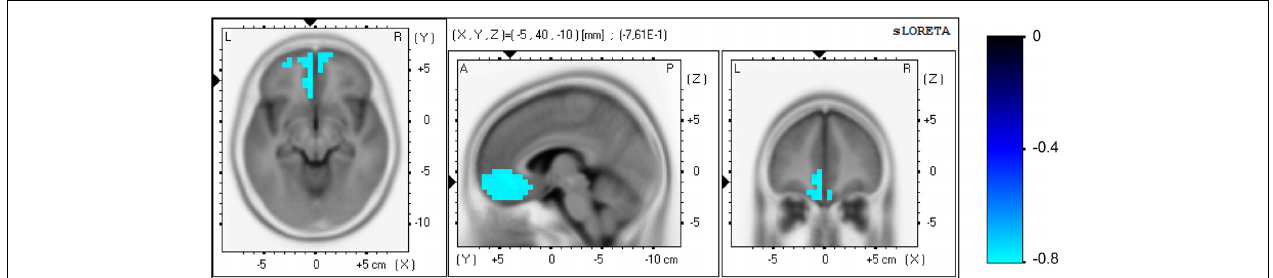
FIGURE 5 | Correlation analysis for the NF group at the brain source level between the pre vs. post increase in the elapsed time variable of the PASAT test and the increase in current density, measured in beta3 band (20–30Hz) in task-related activity. Axial (left), sagittal (middle), and coronal (right) sections of sLORETA are displayed through